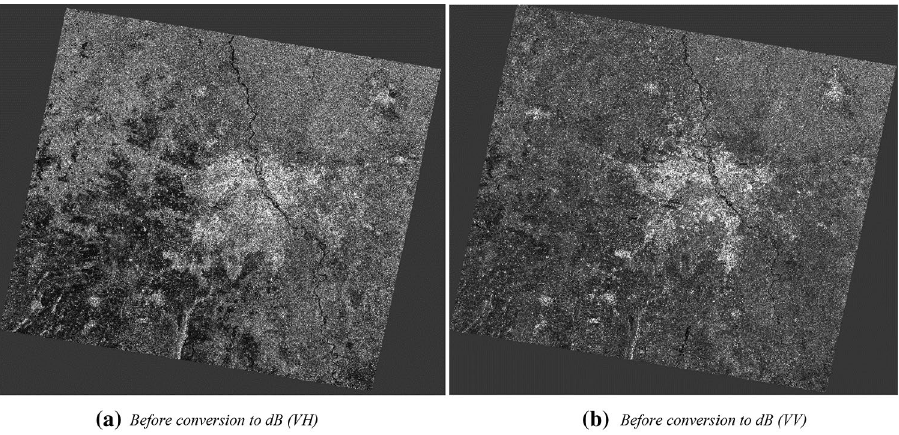
Figure 11. Conversion of the image to dB.